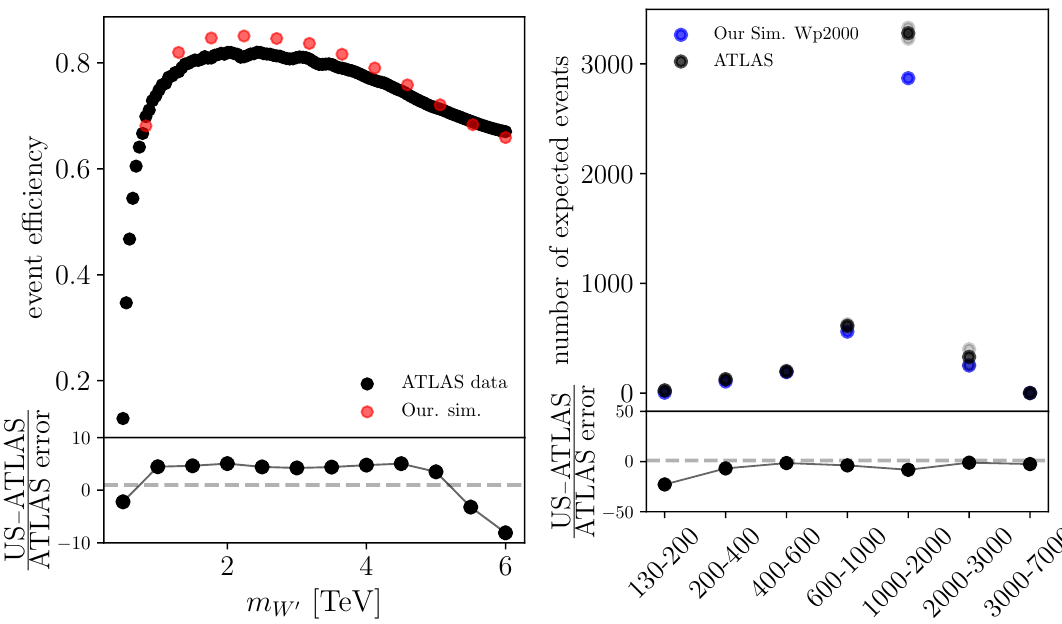
Figure 6 . Validation plots per m W 0 mass point and per m T ATLAS-defined bins. Comparison with the ATLAS expectation is provided in the bottom frames. (left) Event efficiency as a function of m . (right) Number of expected events as a function of m W 0